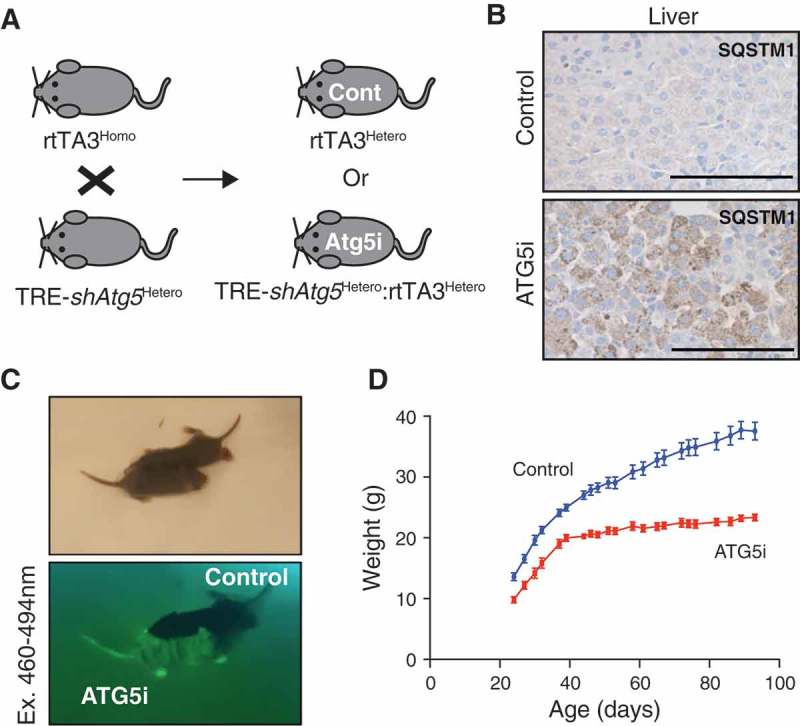
Perinatal survival of ATG5i neonates. (a) Breeding strategy for the generation of ATG5i neonates. A doxycycline-containing diet was fed to the parents who each have 1 component of the 2-component system, and thus are unable to induce Atg5-shRNA. Any embryos with both components, however, will induce the system. Cont, control. (b) IHC analysis of 14-day-old neonates highlights the presence of SQSTM1 aggregates in the livers of ATG5i mice in comparison to control. Scale bars: 100 μm. (c) ATG5i neonates are born at, and survive at, expected Mendelian ratios. They appear indistinguishable from their littermate controls except for their positivity for tGFP (bottom). (d) While initially indistinguishable, ATG5i mice do not show the same growth kinetics (n = 6 males in both conditions).